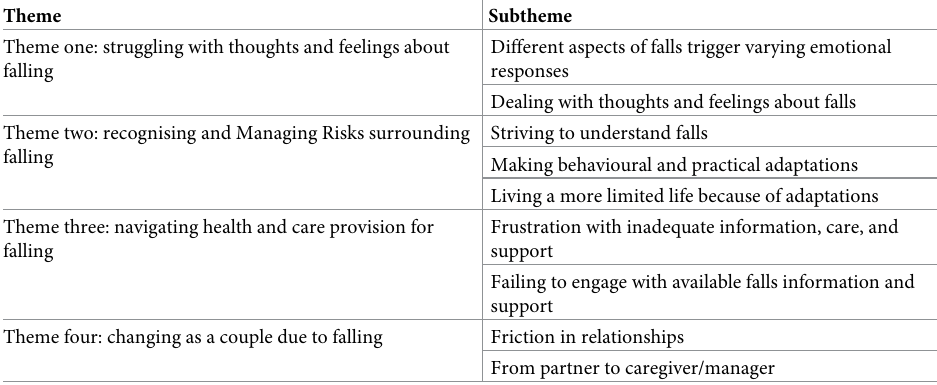
Table 3. Themes and